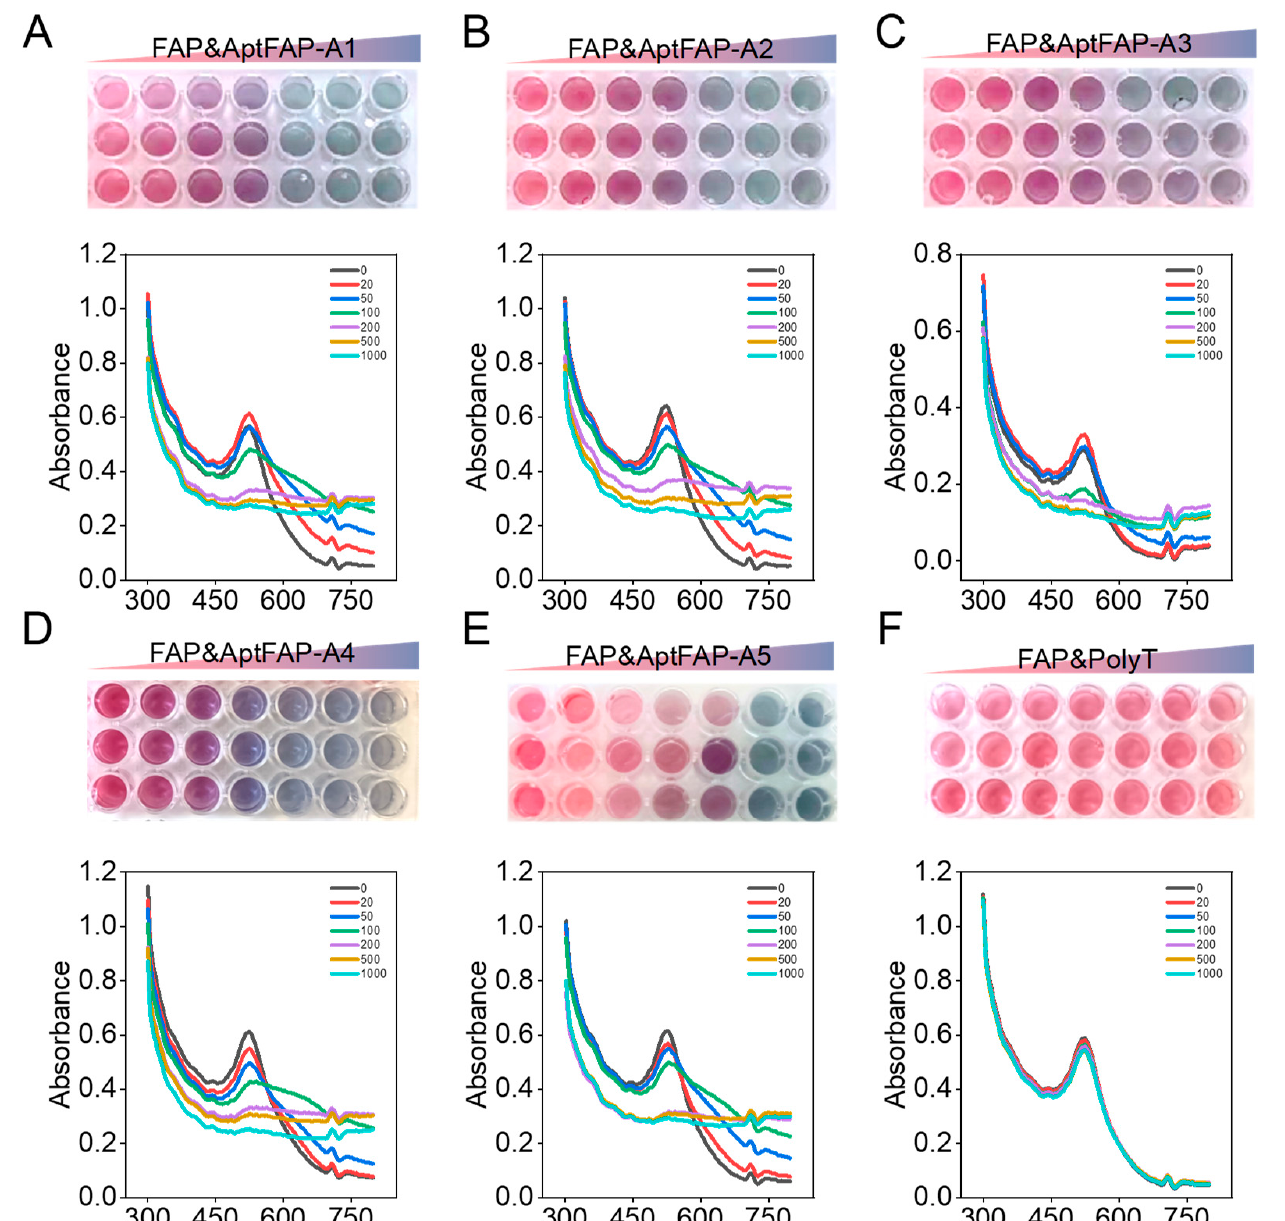
Figure 6. The affinities of candidate aptamers were verified using colloidal gold colorimetry. ( A – F ) UV absorption spectra of target proteins after co-incubation with candidate aptamers AptFAP- A1~AptFAP-A5 and the control group PolyT, respectively. With the increase in the candidate aptamer concentration, the absorption peak of the AuNP solution gradually shifted from 520 nm to 620 nm, and the color changed from burgundy to